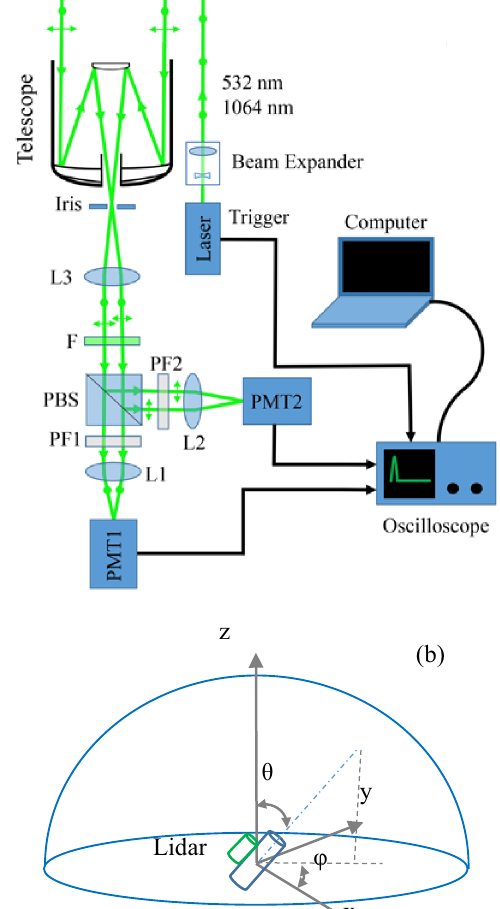
Figure 3 a) Optical setup of SDL; L-lens, PBS- polarizing beam splitter, PF-polarizing filter, b) the scanning scheme of